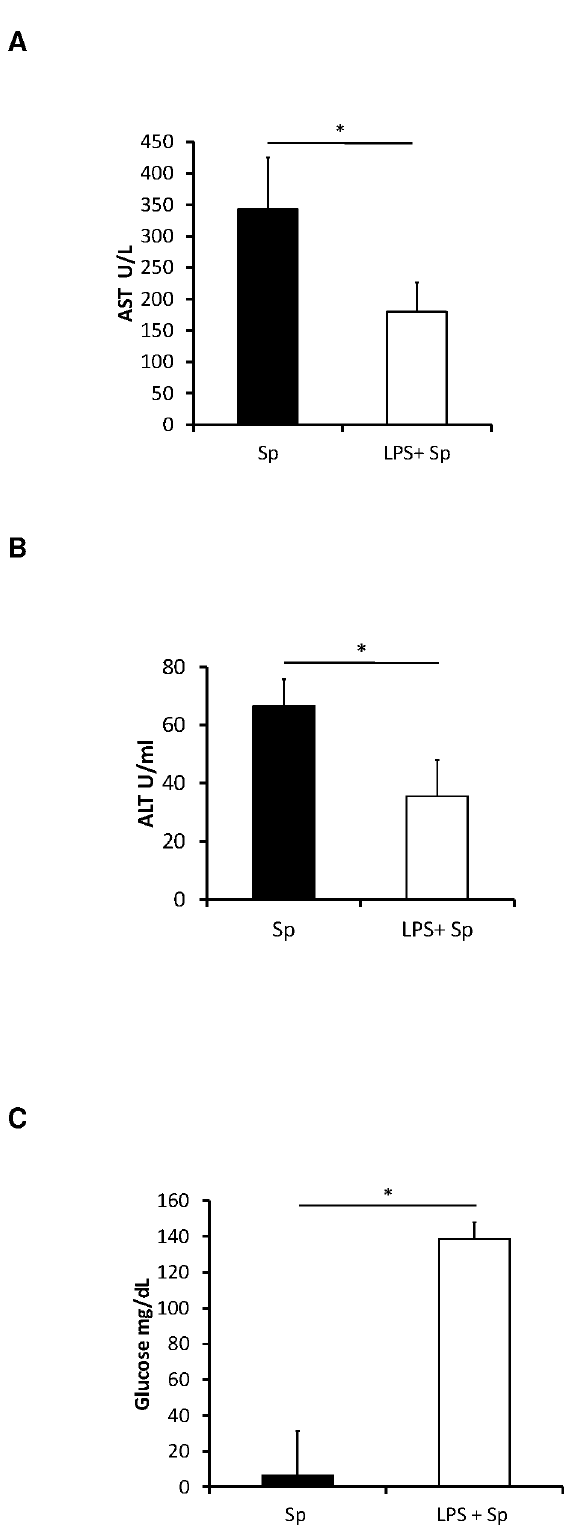
Figure 4. Mean ± SD serum (A) AST,(B) ALT, and (C) glucose concentrations at 6 hours after pneumococcal challenge in mice that received LPS pretreatment compared to controls (N=4 – 6 per group), *t-test, p ,